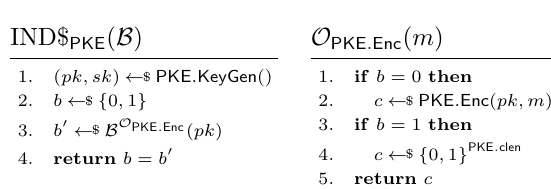
Figure 6: The ciphertext indistinguishability-from-random game for a public-key encryption scheme PKE .